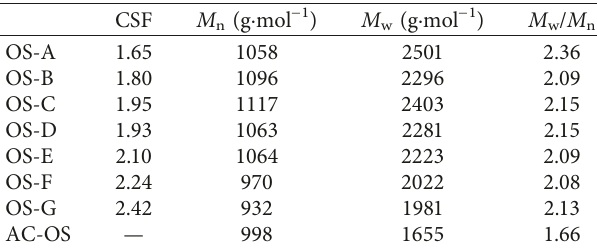
Figure 2: ATR-FTIR spectra of larch lignin samples; for peak identification, see Supplementary Table 3: Results from molecular weight analysis of larch orga- nosolv samples.